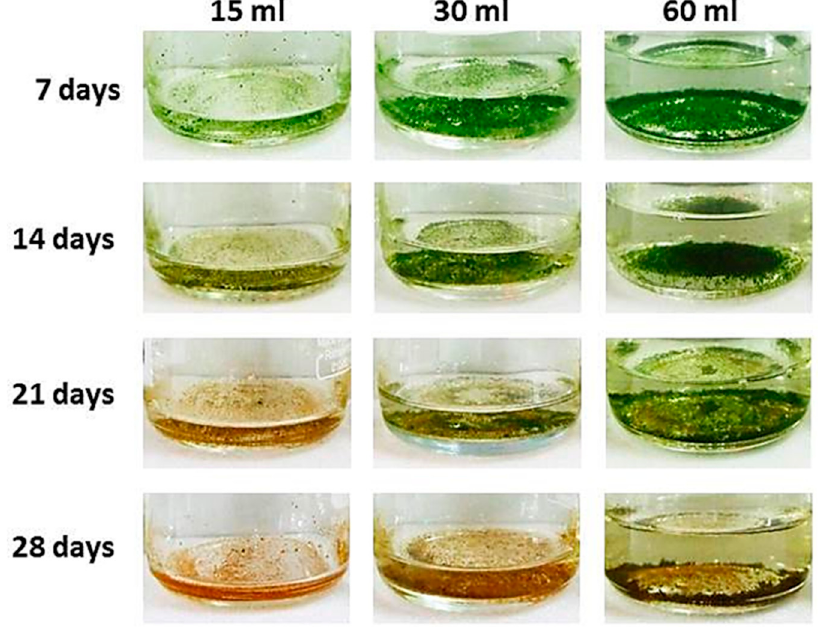
Figure 5. Effect of media volume on Chlorosarcinopsis PY02 growth and cell colour. This experiment was conducted using 50% N TAP liquid medium with initial volumes of 15, 30 and 60 mL in 250 mL Schott Duran bottles.